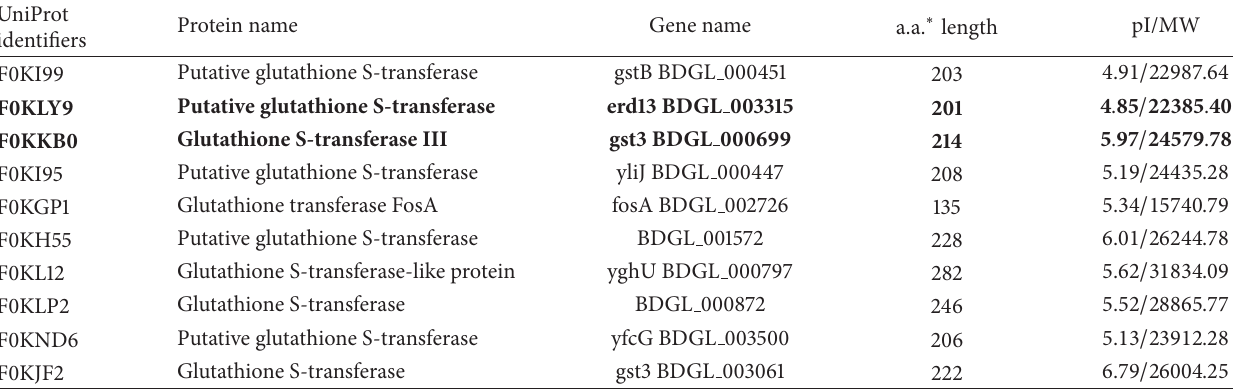
Table 2: List of putative glutathione transferases of Acinetobacter calcoaceticus (strain PHEA-2) retrieved from http://www.uniprot.org/ uniprot/. pI and MW values were computed at Compute pI/Mw (http://www.expasy.org/tools/). Bold indicates that F0KLY9 (putative